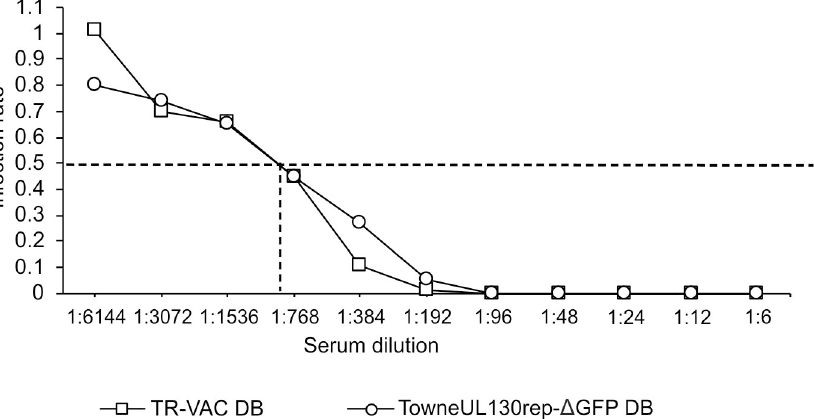
Figure 4. Comparative analysis of the levels of HCMV nt-abs induced in rabbits by intramuscular injection of either TR-VAC DB or TowneUL130rep-ΔGFP DB. Individual sera were serially diluted and tested for neutralization of HCMV strain TR-VAC on HFF indicator cells. The relative levels of neutralization of HCMV were measured by counting nuclei stained positive for IE1 expression. The serum dilution corresponding to 50% neutralization is displayed by dashed lines.